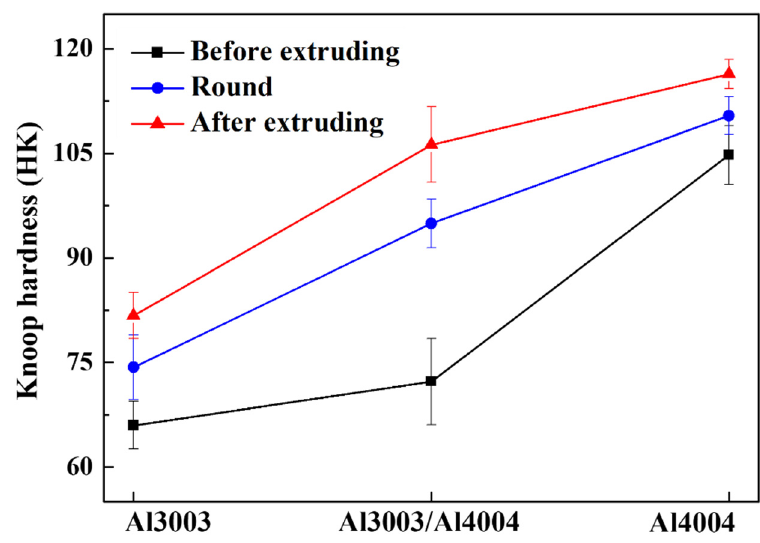
Figure 10. Changes of Knoop hardness in Al3003, Al3003 / Al4004, and Al4004 parts before, during (round), and after extrusion.